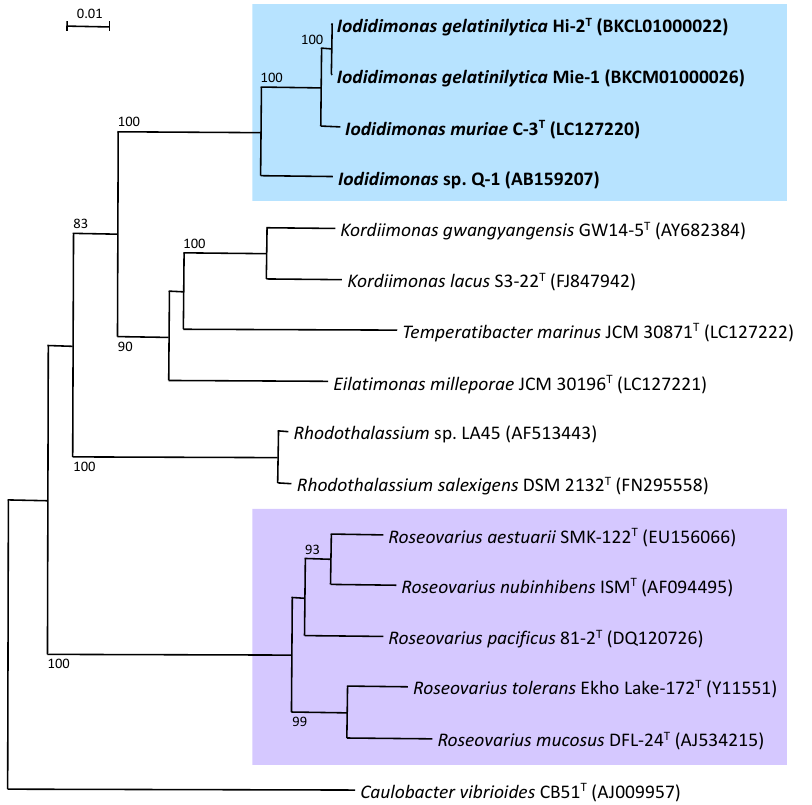
Figure 2. Phylogenetic tree of members of the genus Iodidimonas based on the 16S rRNA gene sequences. The tree was constructed using the neighbor-joining method. Numbers at nodes are bootstrap percentages derived from 1000 replications, and values of 70% or more are shown. Bar: 0.01 substitutions per nucleotide position.